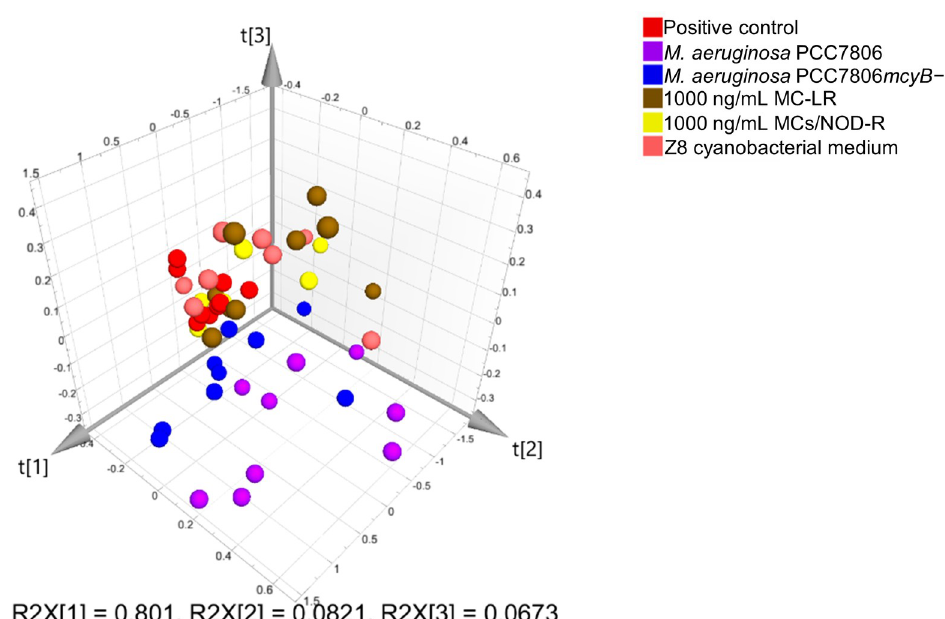
Fig 3. Principal component analysis scores plot including data from high-concentration exposures. 3-D scores plot from unsupervised principal component analysis based on pareto-scaled and positive-control-subtracted hormone concentrations, from high-exposure groups only. The first three components explained 95% of the total variation. The plot shows a larger dispersion of the data from M . aeruginosa PCC7806 exposures, but individual observations from these exposures also clustered further away from the positive control and microcystin exposures.